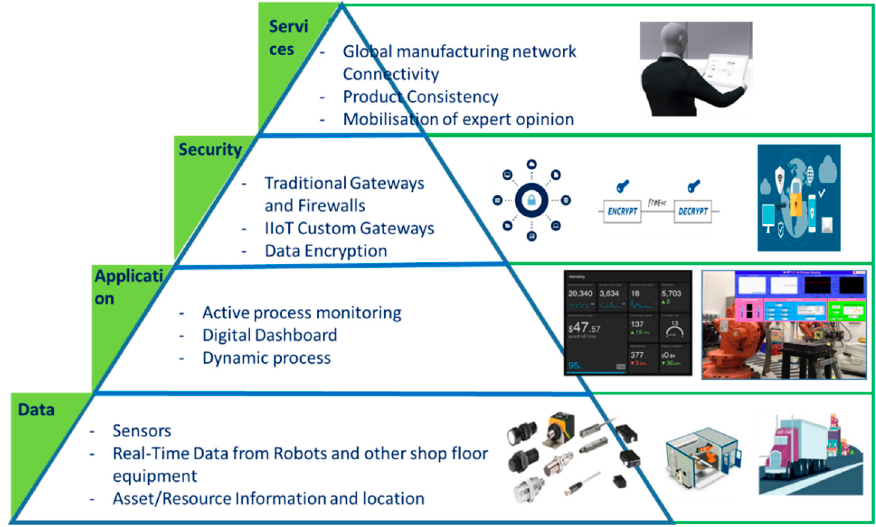
Figure 2. The proposed potential Industrial IoT (IIoT) architecture for the manufacturing industry.